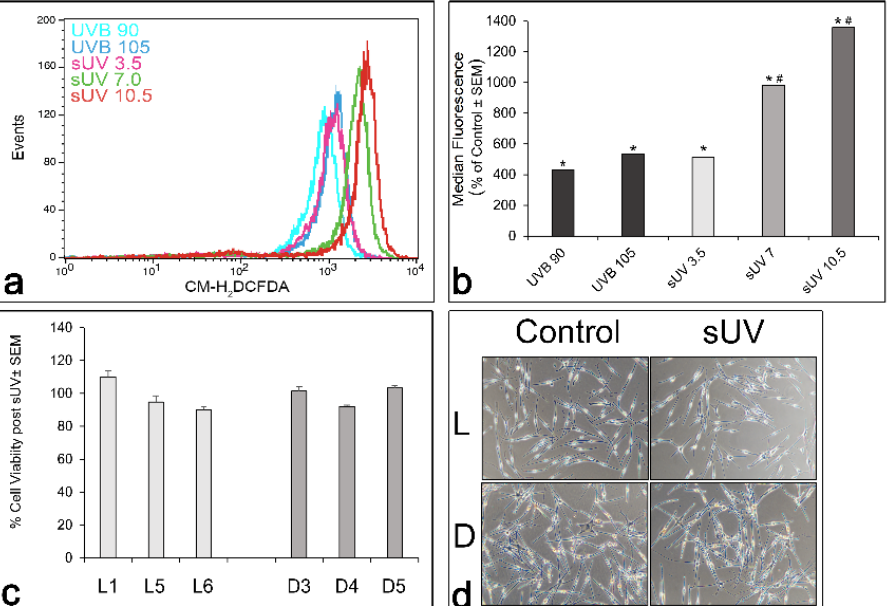
Figure 2. Dose-dependent generation of ROS in response to UVB versus solar UV (sUV) in lightly pigmented melanocytes, and the impact of solar UV on the viability of L and D melanocytes. In ( a ), the histogram represents comparison of the dose-dependent increase in ROS by 90 and 105 mJ/cm 2 UVB and 3.5, 7, and 10 J/cm 2 solar compared to the control, as determined following CM-H 2 DCFDA loading, and a flow cytometry analysis 1 h post-UV irradiation, as described in Materials and Methods. ( b ) The quantitation of the data in ( a ), expressed as the mean ± SEM of triplicate samples/group. * = Statistically significantly different from the respective control group ( p < 0.001); # = statistically significantly different from UVB groups and the other solar UV-irradiated groups ( p < 0.001). ( c ) The effect of 7 J/cm 2 solar UV on the viability of L versus D melanocytes, as measured by the MTT assay 48 h post-irradiation. Each bar represents the mean cell viability of triplicate samples ± SEM. ( d ) Light microscopic view (10× magnification) of the control and solar UV-irradiated L and D melanocytes 48 h post-irradiation with 7 J/cm 2 solar UV.